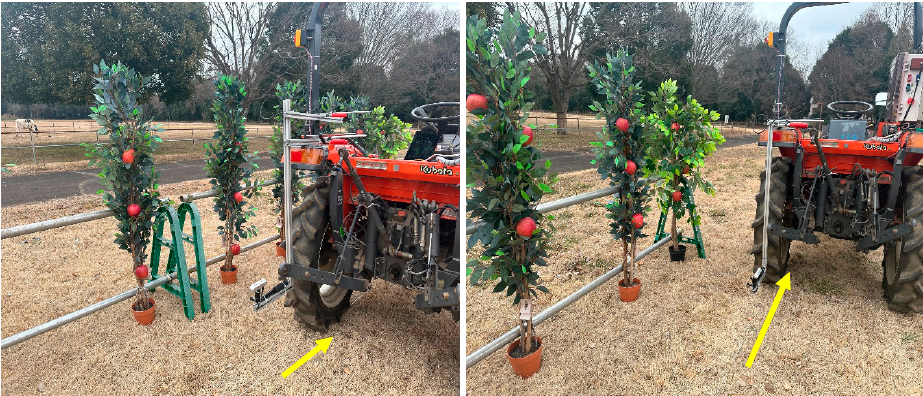
Figure 11. ( a ) A 3D camera at 30° orientation, ( b ) RGB stream corresponding to the 30° camera ori ‐ entation angle, and ( c ) a depth stream.